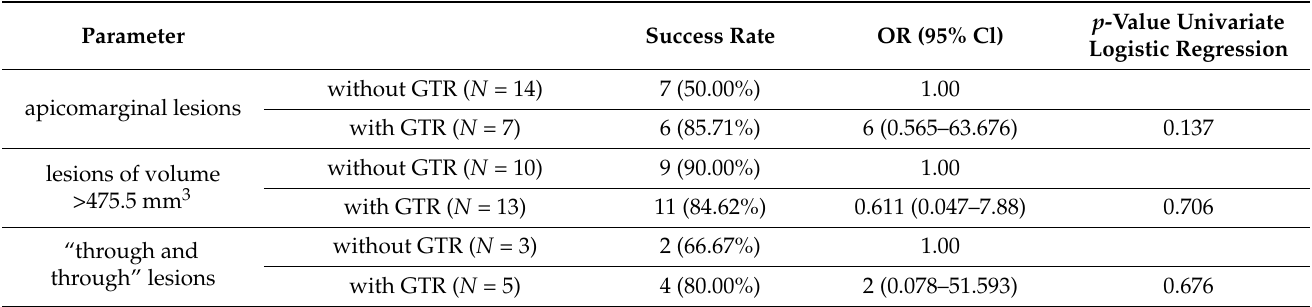
Table 5. Distribution of cases with indications for GTR per outcome; univariate logistic regres- sion